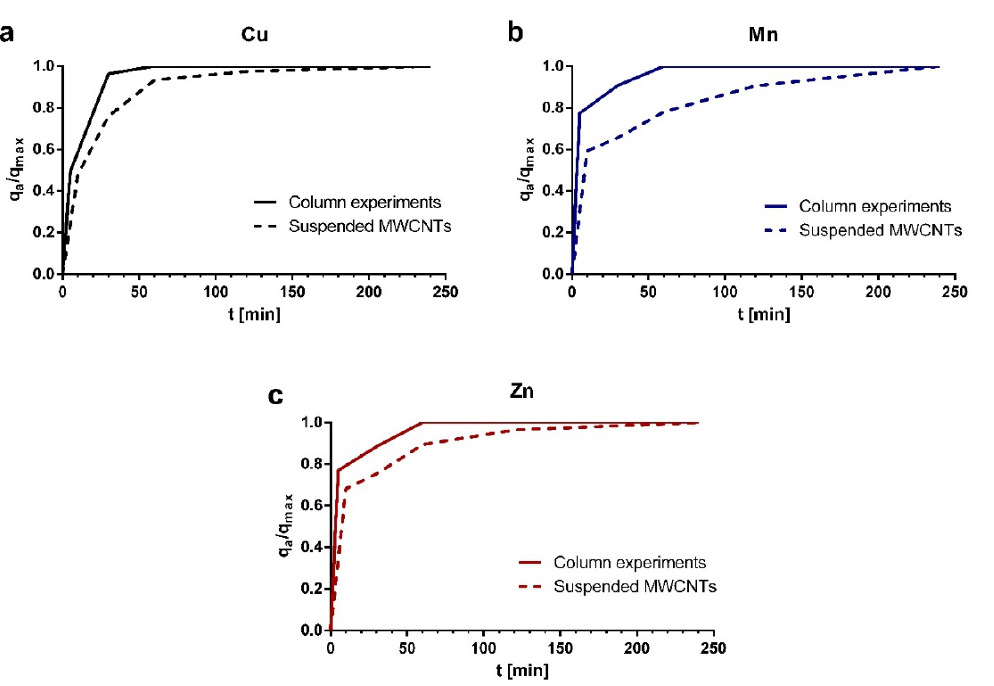
Figure 5. Accumulated sorption capacity (q a ) divided by maximum sorption capacity (q max ) of ( a ) Cu, ( b ) Mn, and ( c ) Zn using polyurethane filters dyed with oxidized MWCNTs ink in column experiments (continuous lines) and suspended oxidized MWCNTs in batch experiments (dashed lines).